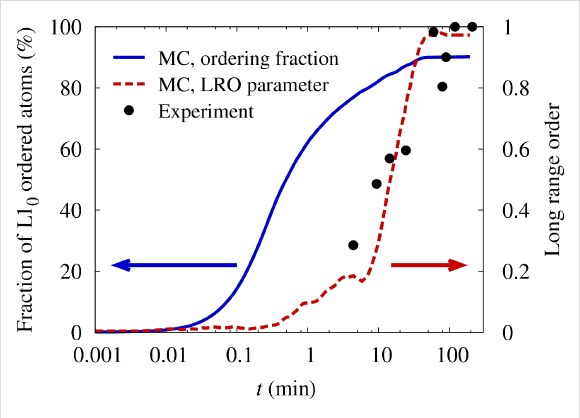
Figure 1: Comparison of simulated ordering kinetics in bulk FePt alloys with results from annealing experiments on sputtered thin films [18]. The temperature in both, experiment and simulation, is 973